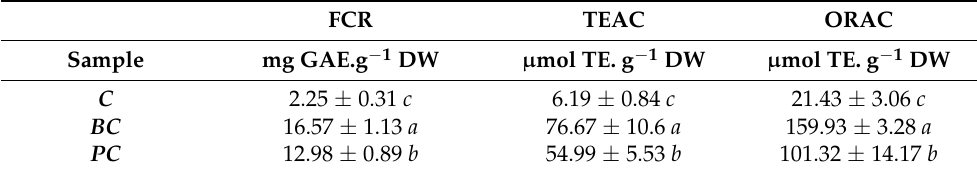
Table 2. Folin–Ciocalteu reagent (FCR) reducing capacity and antioxidant capacity (by TEAC and ORAC assays) in orange carrot (OC), black carrot (BC) and purple “Polignano” carrot (PC) extracts.